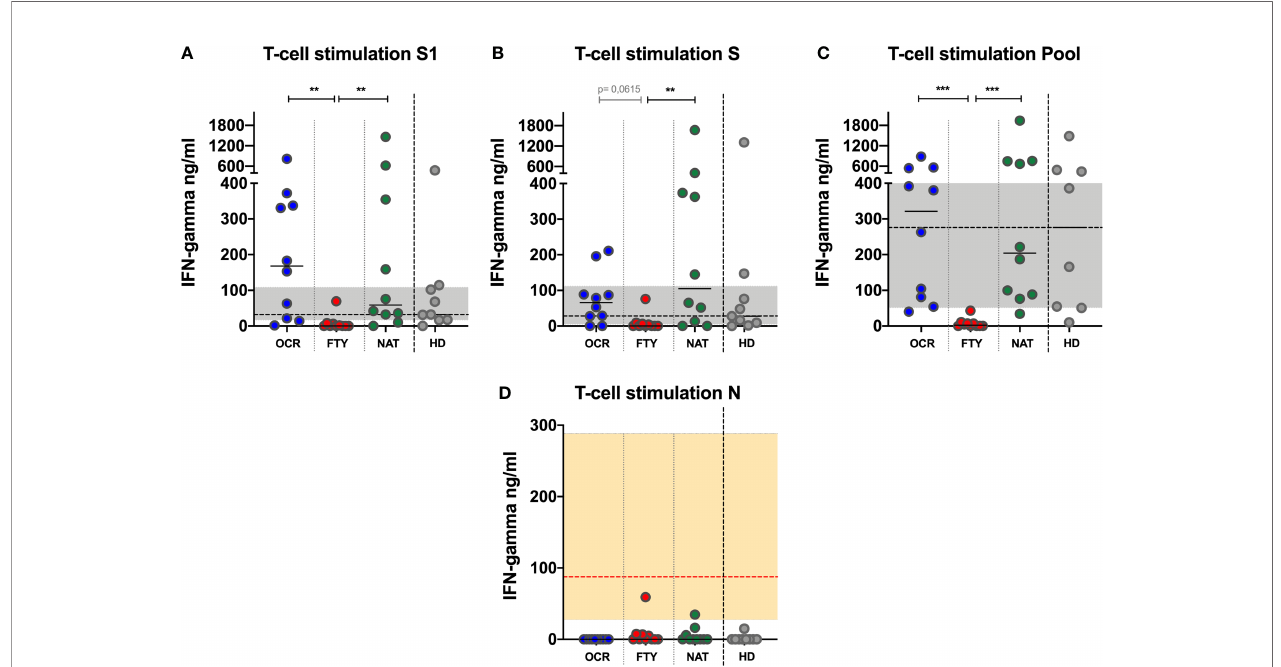
FIGURE 3 | IFN- g production upon Spike and Nucleocapside peptide libraries stimulation of whole blood of PwMS. IFN- g production upon S1 (A) , S (B) and N (D) peptide libraries is represented for all the PwMS enrolled in the study. Furthermore, IFN- g production upon pooled peptide (Pool=S1+S+N) is represented (C) . The differences among the three groups were assessed using the Kruskal-Wallis test, and the Dunn ’ s multiple comparison post-test, after correction for multiple comparisons. The level of statistical signi fi cance is reported. (A – C) . Horizontal continuous segments represent medians. Horizontal dotted black line and the gray area represent the median value and the interquartile range [IQR] observed in 9 healthy donors age and sex matched with PwMS. (D) . Horizontal dotted red line and the orange area represent the median (60,6 ng/ml) and IQR (16,3-346,3 ng/ml) observed in 5 PwMS on ocrelizumab treatment with symptomatic COVID-19 disease, which have been previously described (12). All the PwMS with the exception of 2 subjects (1 on fi ngolimod and 1 on natalizumab) showed IFN- g production upon N stimulation comparable to those observed in the 5 PwMS on ocrelizumab with symptomatic COVID-19 disease. PwMS, people with multiple sclerosis; OCR, ocrelizumab group (blue); FYT, fi ngolimod group (red); NAT, natalizumab group (green); HD, healthy donors (gray). ** 0,01<p< 0,001; *** 0,001<p<